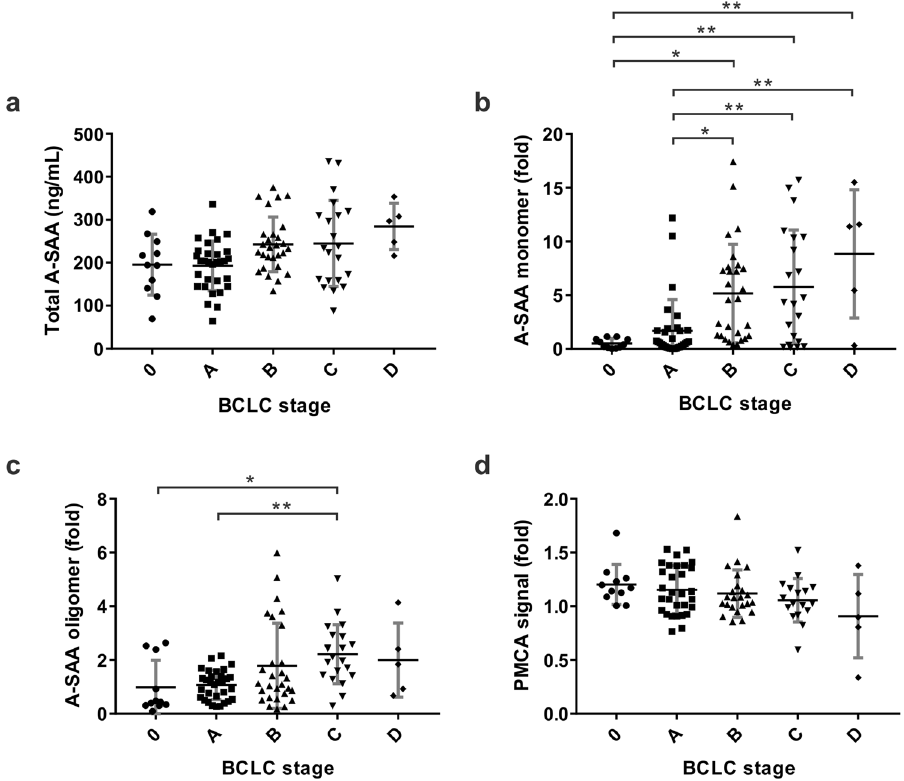
Figure 3. The level of A-SAA derived biomarkers at different HCC BCLC stages. A total of 96 serum samples from stage 0 (n = 11), stage A (n = 31), stage B (n = 28), stage C (n = 21), and stage D (n = 5) were measured and